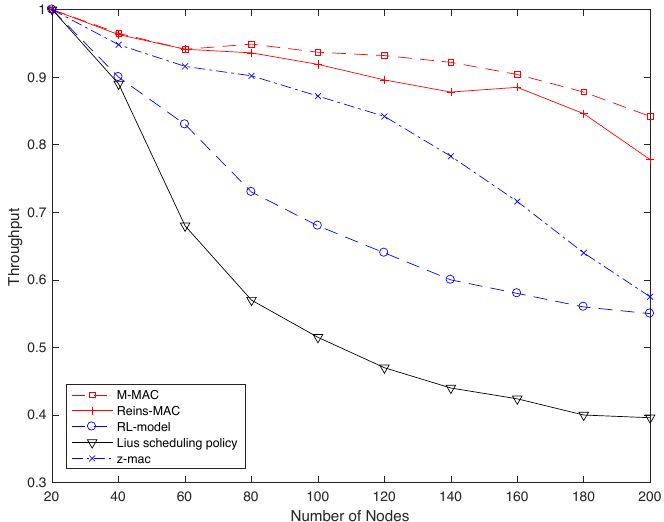
Figure 11. The achieved throughput versus the number of